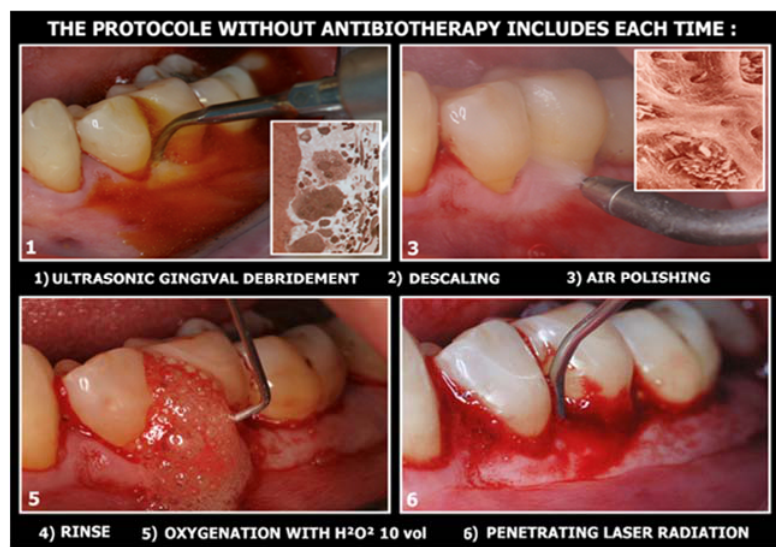
Figure 2. The 6 clinical steps for dye ‐ free photodynamic therapy.